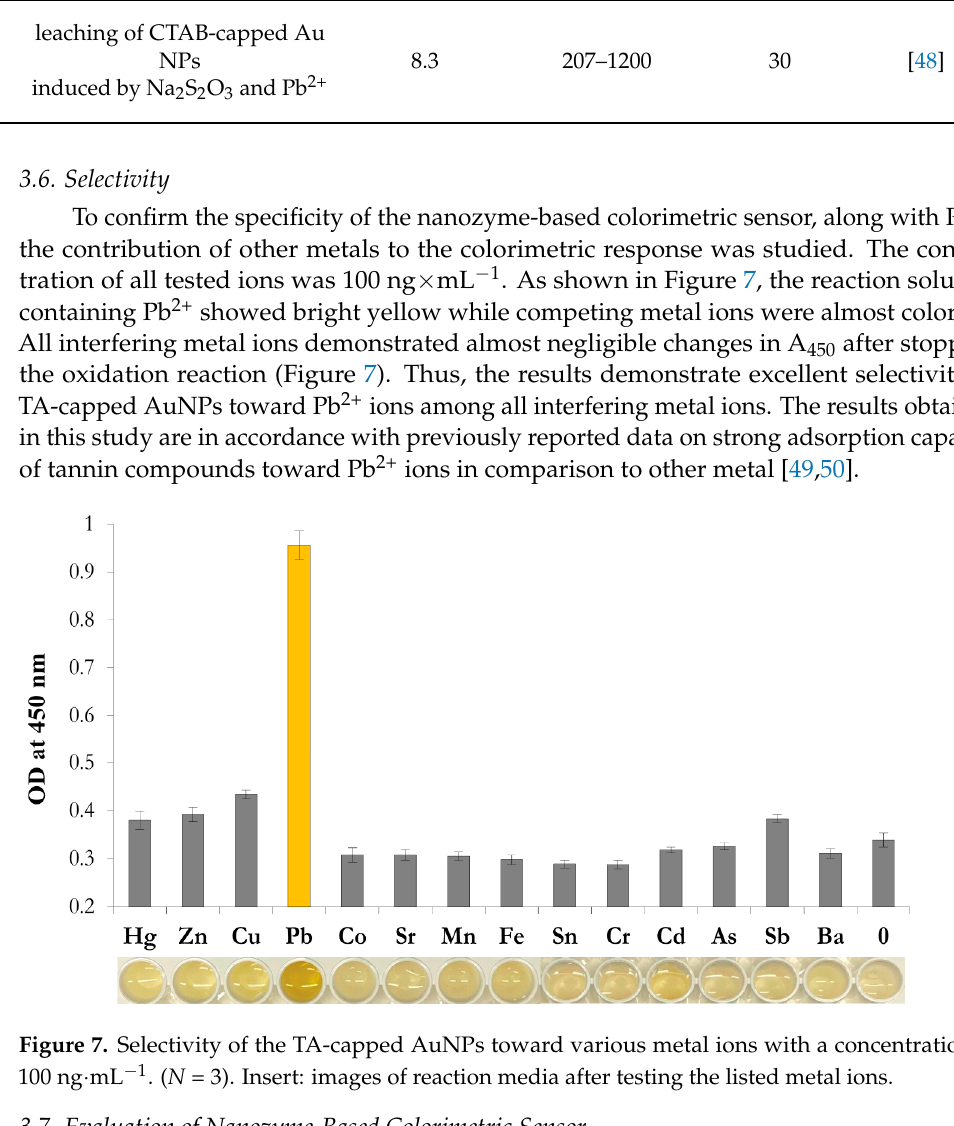
Table 3. Colorimetric detection of Pb 2+ in spiked water samples .